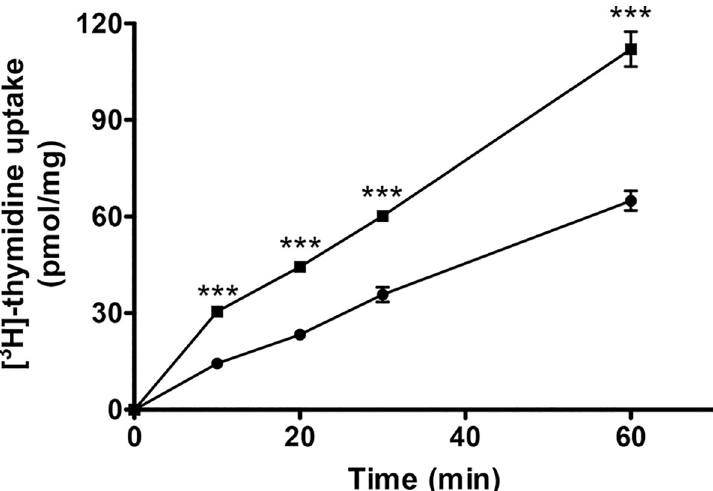
Fig 2. Transport of thymidine in L . infantum transfected with the nucleoside transporter NT1. The uptake of thymidine in L . infantum transfected with pSP72 α puro α ( ● ) or with pSP72 α puro α -NT1 ( ■ ). Average of three experiments with standard error of mean (SEM) are presented, ��� p < 0.005.